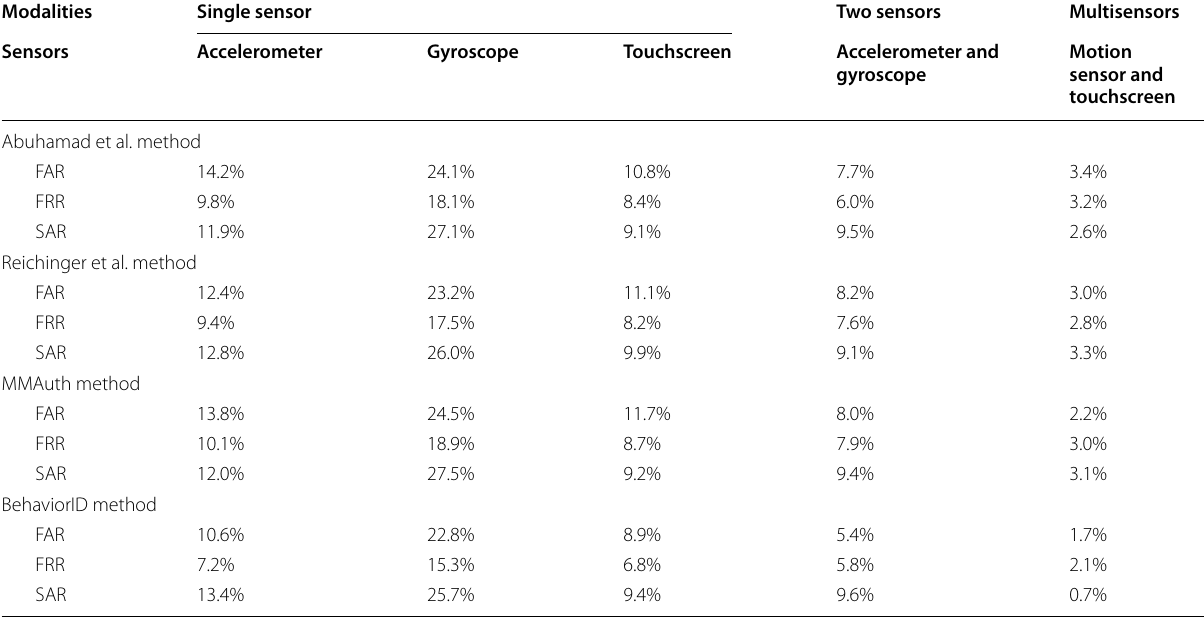
Table 4 Estimated values of FAR, FRR, and SAR during user authentication during free-text typing in various contexts (BB-MAS dataset) with modern and proposed methods